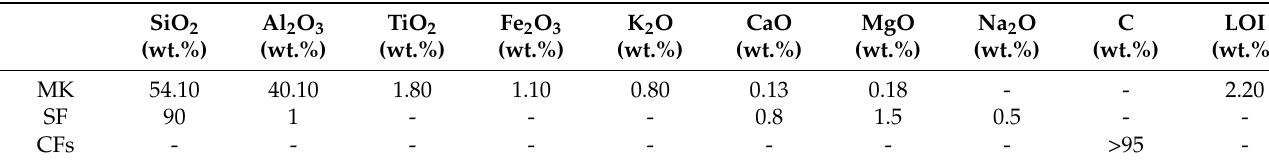
Table 1. The chemical composition of raw materials.